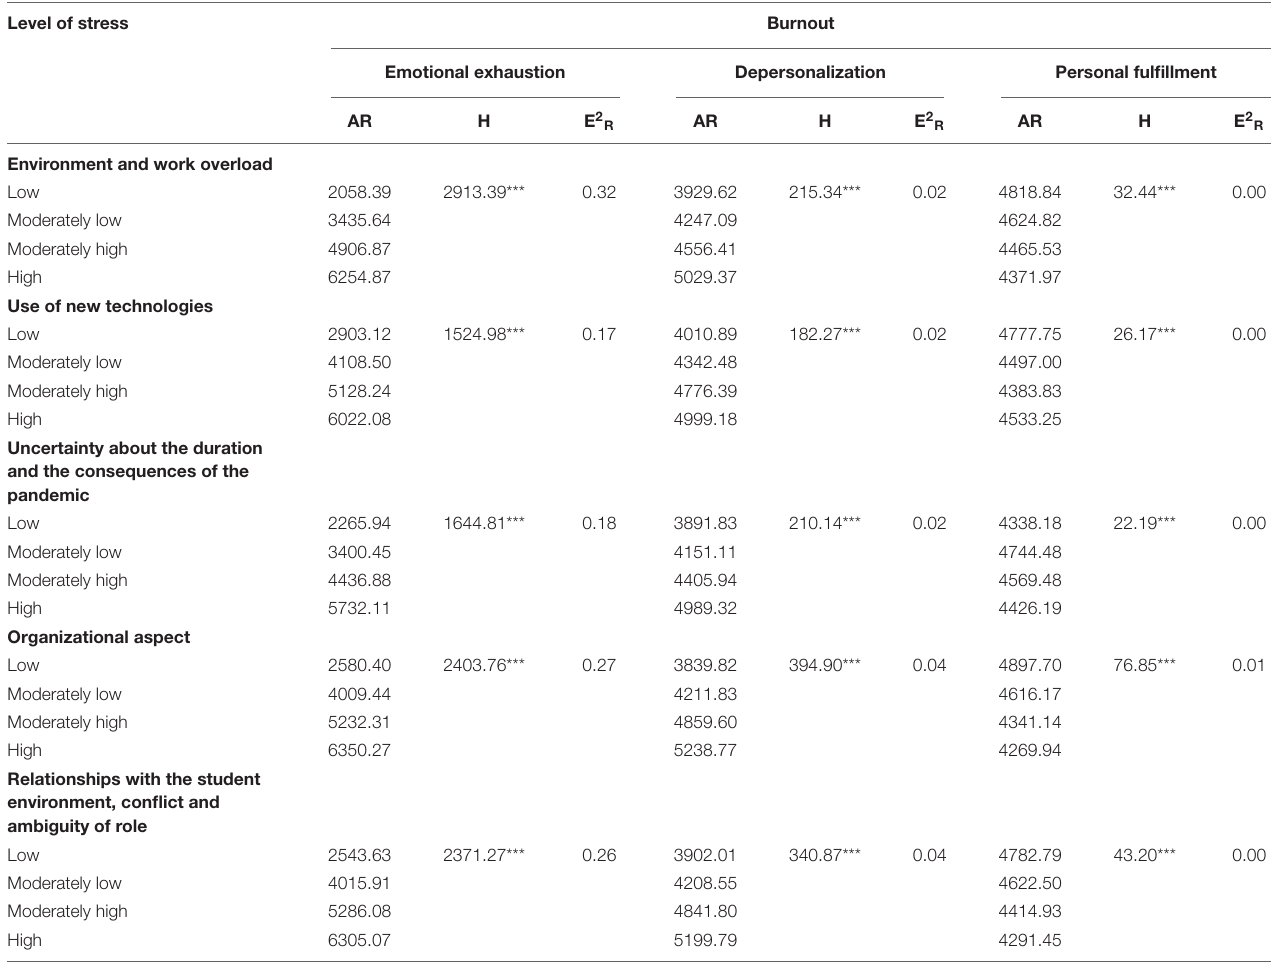
TABLE 4 | Results of the Kruskall Wallis test of variance for Burnout according to the Level of stress. Level of stress Burnout Emotional exhaustion Depersonalization Personal fulfillment